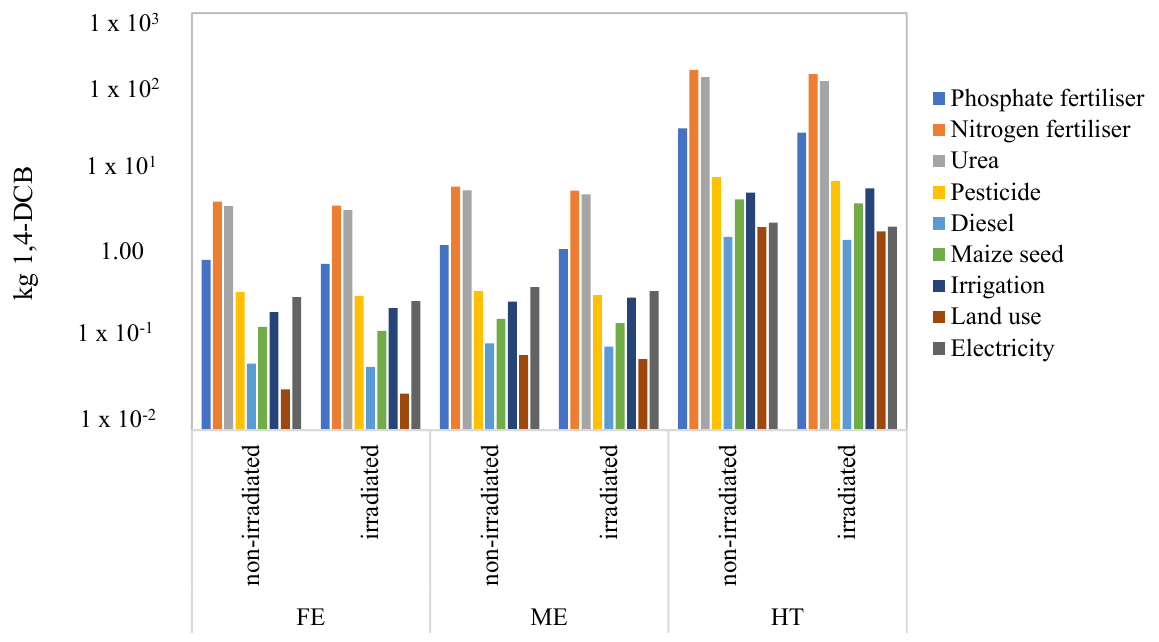
Figure 3. Comparison of contributions by laser-induced and conventional production to environmental impacts on marine ecotoxicity (ME), freshwater ecotoxicity (FE), and human toxicity (HT). The rate of the human toxicity indicators of non-irradiated seeds was more than the irradiated seeds. According to the rate of environmental indicators in Figures 2 and 3, most inputs are related to nitrogen fertilizer consumption, electricity consumption, diesel fuel, and pesticide consumption. Thus, some management approaches should be presented to reduce these